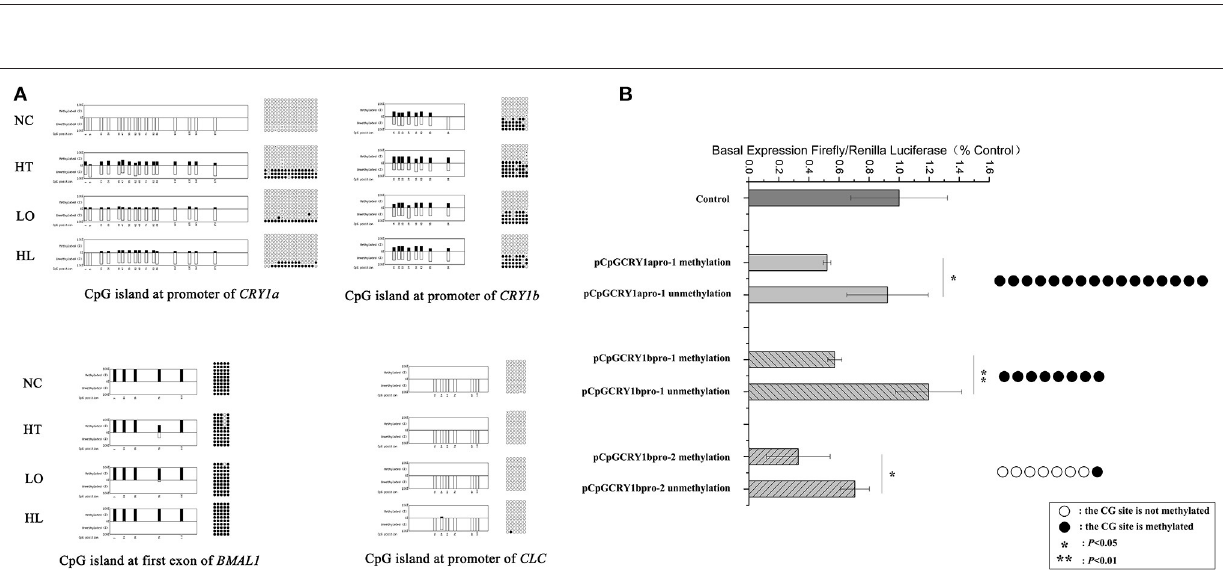
FIGURE 7 | (A) Methylation sites of CRY1a , CRY1b , BMAL1 , and CLC under heat stress, hypoxia stress, and heat–hypoxia stress. The histogram represents the proportion of methylation and unmethylation, black represents methylation and white represents unmethylation. Dot graph: each row represents a single clone, 10 replicates. Each dot represents a CpG dinucleotide, the white dot represents unmethylated CpG, and the black dot represents methylated CpG. (B) Promoter activity of CRY1a , CRY1b, CpGCRY1apro-1, and CpGCRY1bpro-1 selected all methylated sequences from (A) , and CpGCRY1bpro-2 selected the methylation sequence at site 84 from (A) (the sequence was screened by repeated